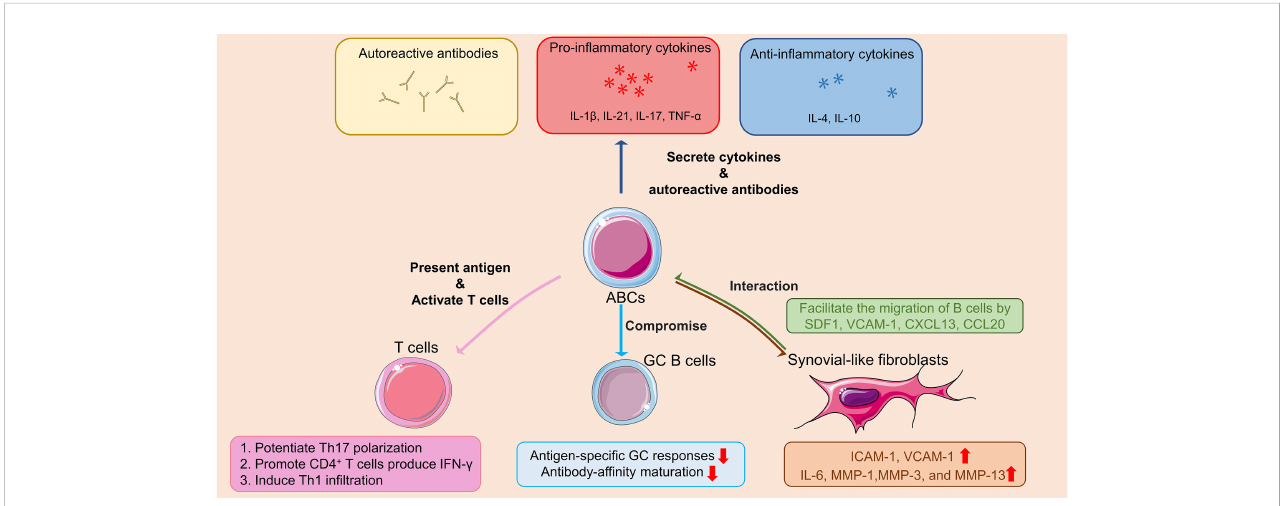
FIGURE 2 Schematic diagram outlining the role of ABCs in the pathogenesis of RA. In RA patients, ABCs secrete autoreactive antibodies to contribute to autoimmune diseases, in fl ammatory cytokines (i.e. TNF- a , IL-17 and IL-21) to promote in fl ammation, as well as anti-in fl ammatory cytokines (i.e. IL-4 and IL-10) with unknown effect. ABCs also act as antigen presenting cell promoting IFN- g secretion of CD4 + T cell, potentiating Th17 polarization, and Th1 in fi ltration. The antigen-speci fi c GC responses and antibody-af fi nity maturation are compromised by ABCs in GC B cells. At sites of in fl ammatory arthritis, FLS secretes chemokines that facilitate the migration of ABCs into the in fl amed joints, forming ABCs-FLS interaction and further inducing activation of FLS with increased in fl ammatory cytokines and metalloproteinases production. The Figure was partly generated using Servier Medical Art, provided by Servier, licensed under a Creative Commons Attribution 3.0 unported license. ABCs: Age/autoimmunity-associated B cells; RA: rheumatoid arthritis; TNF- a : tumor necrosis factor- a ; IL-1 b : interleukin-1 b ; IL-4: interleukin-4; IL-6: interleukin-6; IL-10: interleukin-10; IL-17: interleukin-17; IL-21: interleukin-21; IFN- g : interferon- g ; GC: germinal center; FLS: synovial-like fi broblasts; SDF1: stromal cell-derived factor-1; VCAM-1: vascular cell adhesion molecule 1; CXCL13: C-X-C Motif Chemokine Ligand 13; CCL20: chemokine (C-C motif) ligand 20; ICAM-1: intercellular cell adhesion molecule-1; MMP-1: matrix metallopeptidase 1; MMP-3: matrix metallopeptidase 3; MMP-13: matrix metallopeptidase